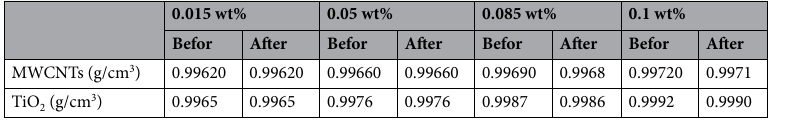
Table 3. The density of nanofluid samples before and after the